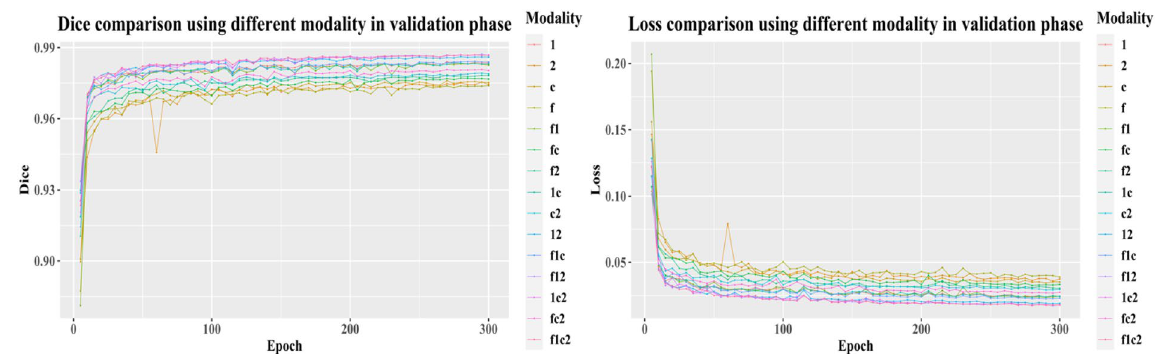
Figure 6. The change of dice (left) and loss (right) in the training phase. In the legend, 1, 2, c, and f represent T1, T2, T1ce, and T2-FLAIR, respectively. For example, f1ce represents that the combination has all four image sequences.